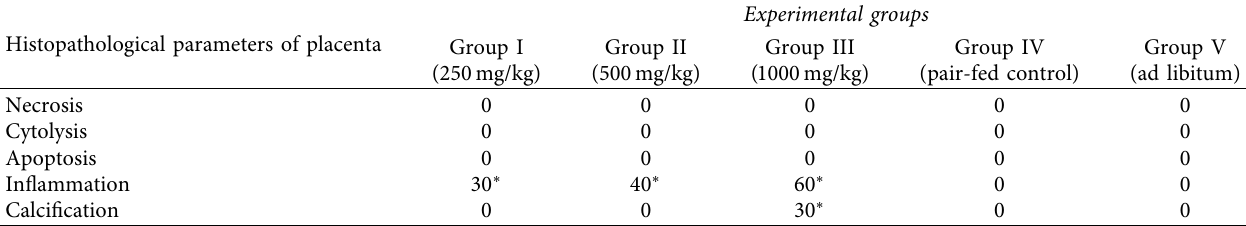
Table 8: Distribution of placental histopathological manifestations across experimental groups. Histopathological parameters of